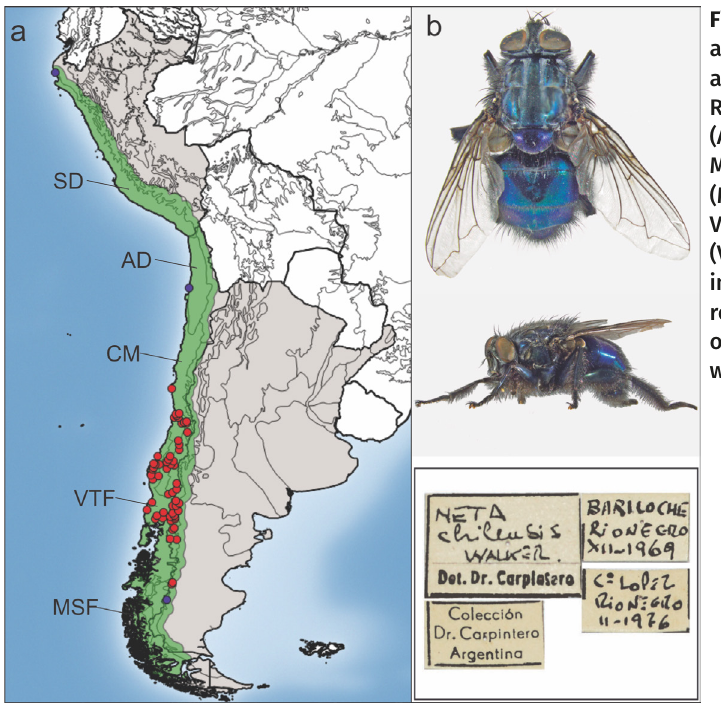
Figure 1.a. Argentina, Chile and Peru in gray. Study area of the ENM in